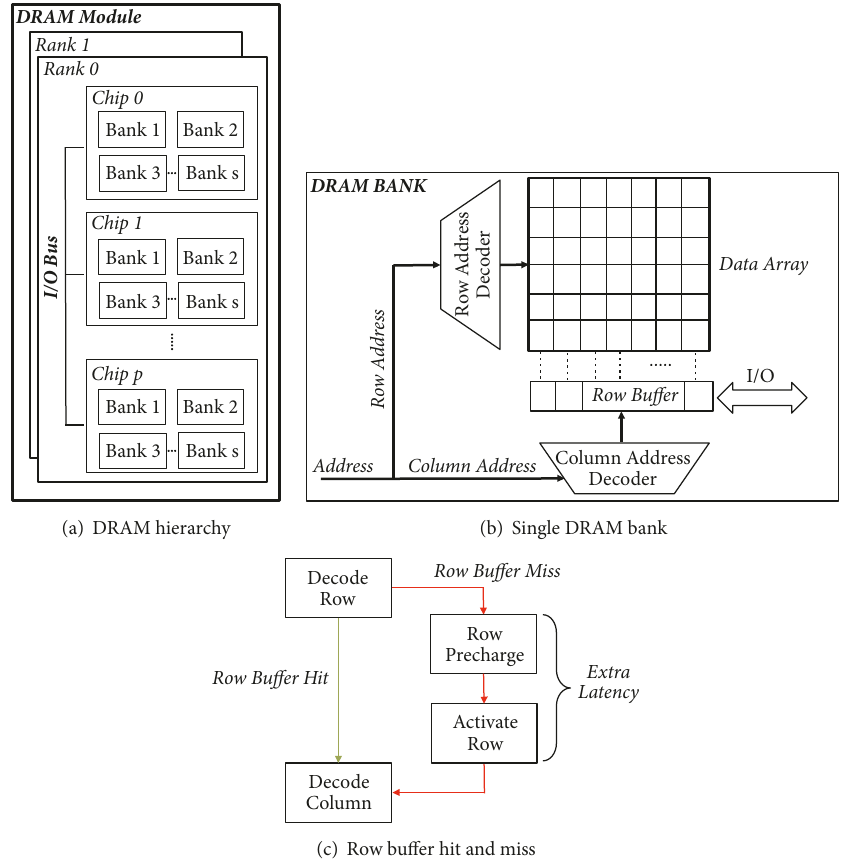
Figure 2: (a) An overview of the DRAM hierarchy. (b) Image showing the structure of a single DRAM bank. (c) Flow chart explaining additional latency introduced when a new row has to be referred to in the row buffer to access a specific